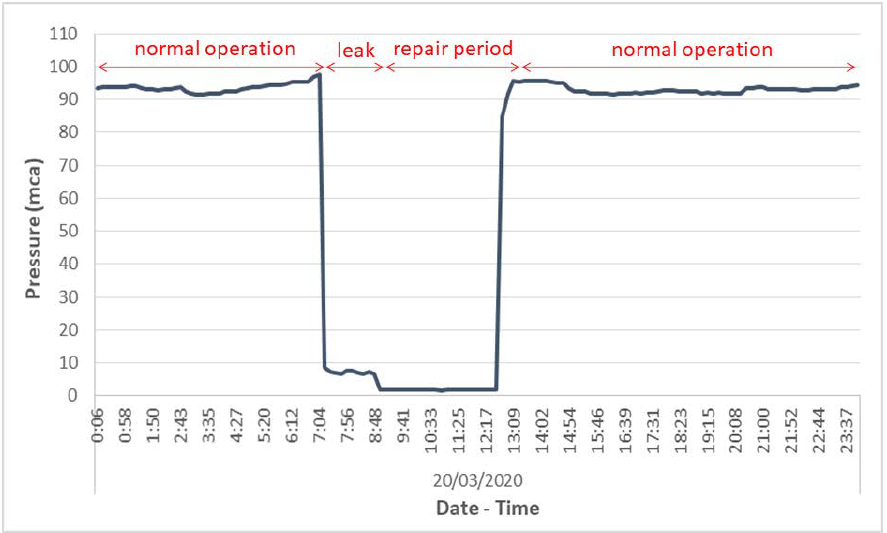
Figure 13. Pressure diagram in a leak event.